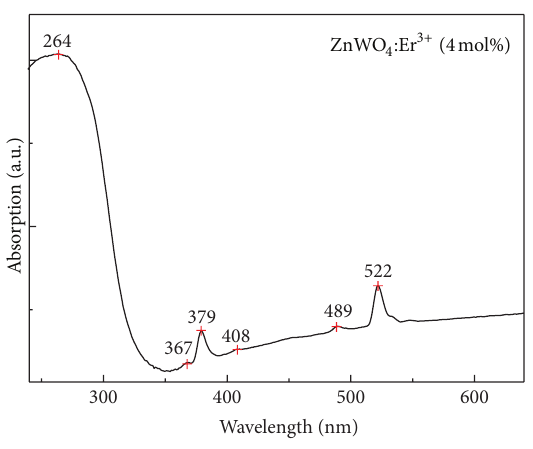
Figure 5: Absorption spectra of ZnWO 4 :Er 3+ (4mol%). Figure 6: PL spectra of ZnWO 4 :Er 3+ with different molar concen- trations of Er 3+